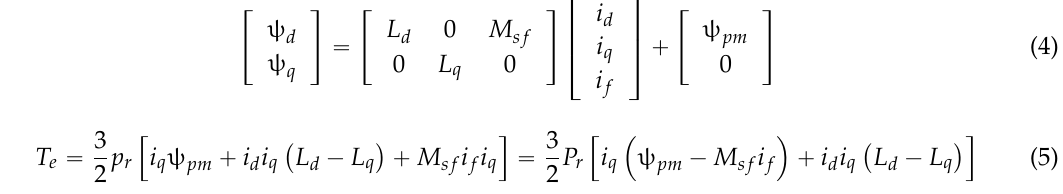
Figure 9. Cont. Figure 9. Variation of torque ripple values by different field currents. ( a ) Employing ferrite;